Question: Draft a figure caption describing what is shown.
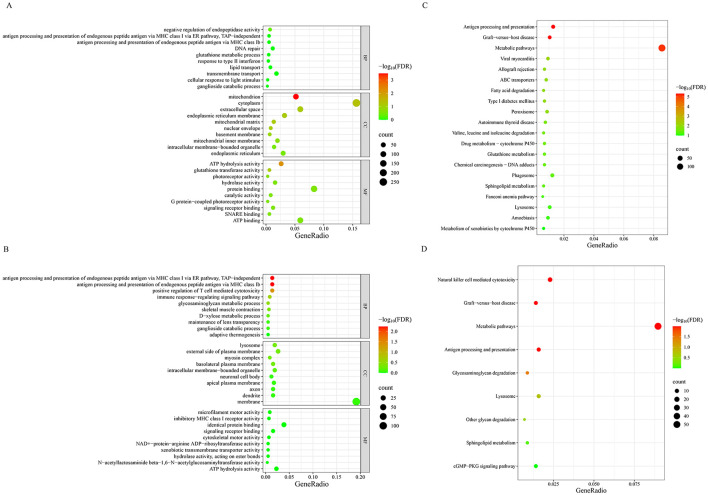
Answer: Functional enrichment analysis of cis-eQTL genes. (A) Results of the GO enrichment analysis of eGenes in Xinjiang brown cattle. (B) Results of the GO enrichment analysis of eGenes in Chinese Simmental cattle. (C) KEGG enrichment results of eGenes from Xinjiang brown cattle. (D) KEGG enrichment results of eGenes from Chinese Simmental cattle. The x-axis represents GeneRatio, dot size represents gene count (Count), and dot color represents FDR-adjusted P -values (Benjamini-Hochberg correction). Only terms with nominal P < 0.05 are shown.